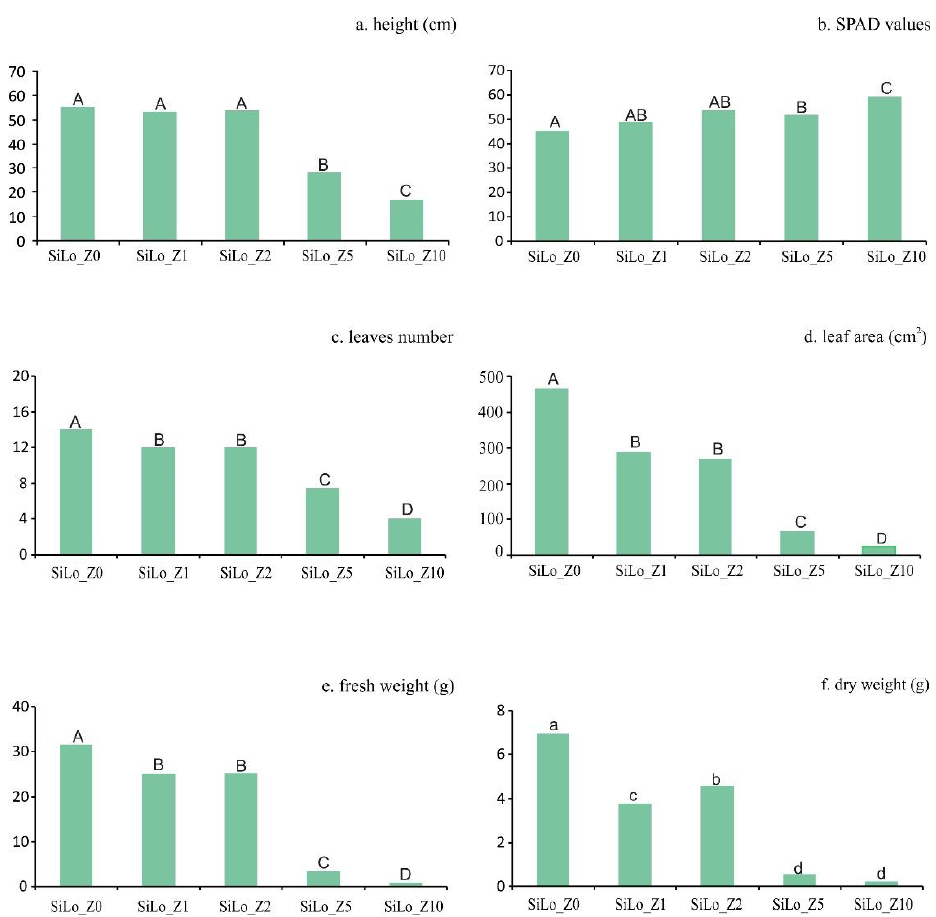
Figure 7. ( a ) Plant height, ( b ) SPAD values, ( c ) leaf number, ( d ) leaf area, ( e ) fresh weight, and ( f ) dry weight of sunflower plant at the flower bud stage, grown on soil treated with different percentages of zeolite (0–10%). Values are means (n = 6). Data presented in each graph were analyzed by one-way ANOVA followed by DMRT. Different uppercase and lowercase letters above the bars are significantly different at p < 0.01 and at p < 0.05, respectively. SiLo_Z0: soil without zeolite; SiLo_Z1: soil with 1% of zeolite; SiLo_Z2: soil with 2% of zeolite; SiLo_Z5: soil with 5% of zeolite; SiLo_Z10: soil with 10% of zeolite.